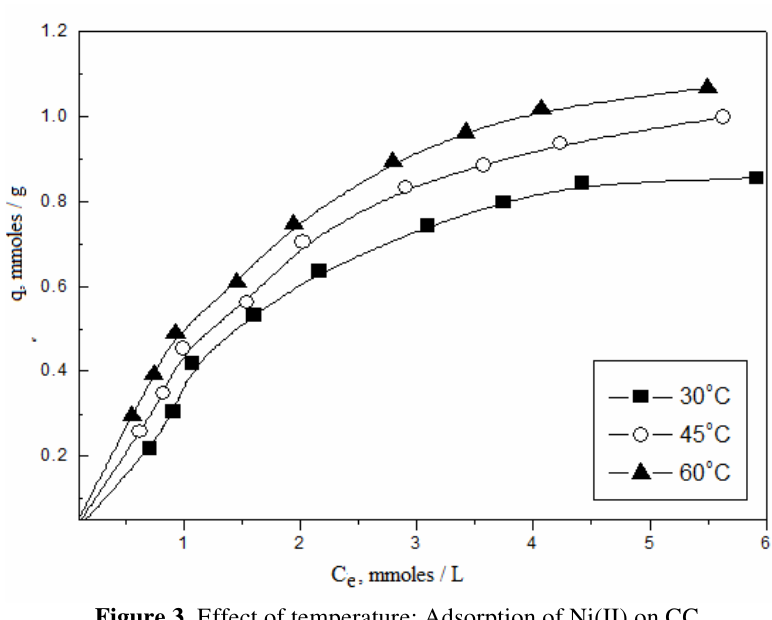
Figure 3. Effect of temperature: Adsorption of Ni(II) on